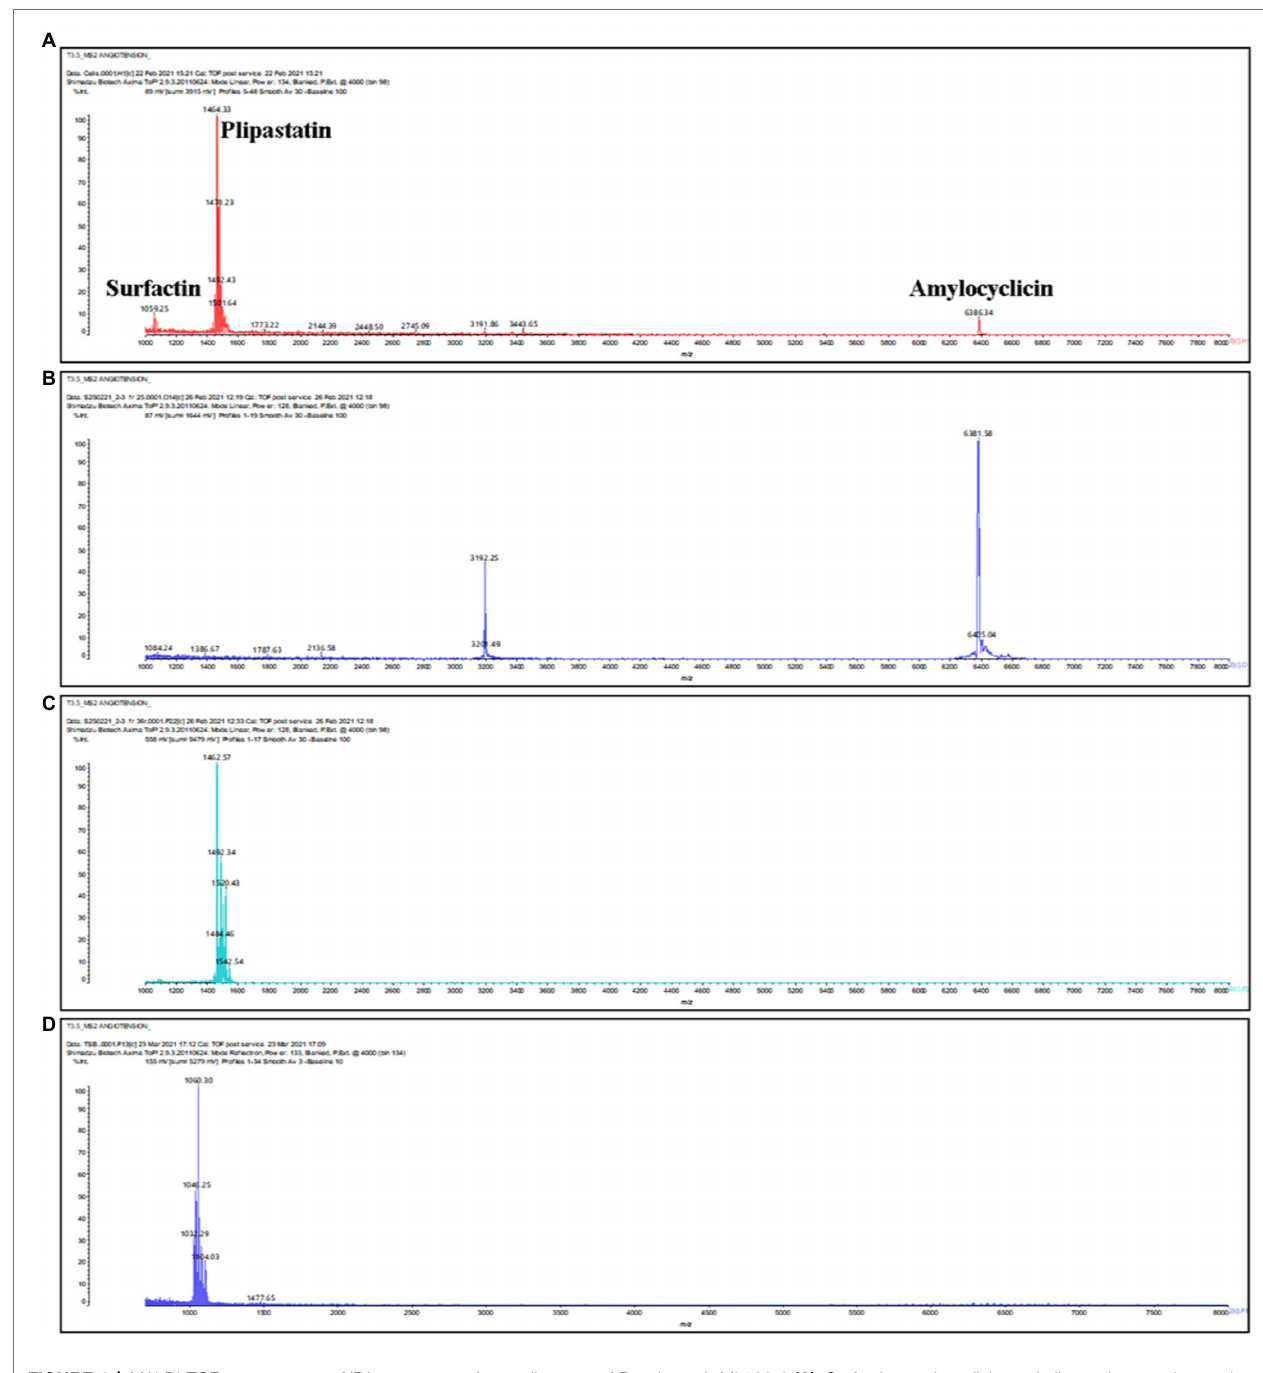
FIGURE 4 | MALDI-TOF mass spectra of IPA supernatant from cell extract of B. velezensis ML122-2 (A) . Surfactin, amylocyclicin, and plipastatin were detected at m/z 1,059.25, 1,464.33 and 6,381.58, respectively. (B,C) Purification of amylocyclicin and plipastatin by RP-HPLC. The active fractions eluted at time interval of 25–28 and 31–37 min in a gradient of 40–85% propan-2-ol 0.1% trifluoroacetic acid represented the peaks of purified amylocyclicin ( m/z 6,381.58 [M + H] + and 3,192.25, the doubly charged form) and plipastatin ( m/z 1,462.57, 1,484.46 1,492.32, 1520.43 and 1542.54), respectively. (D) Partial surfactin purification via solvent extraction of B. velezensis ML122-2 from supernatant revealing corresponding masses at m/z 1,032.29, 1,046.25, 1,060.30 and